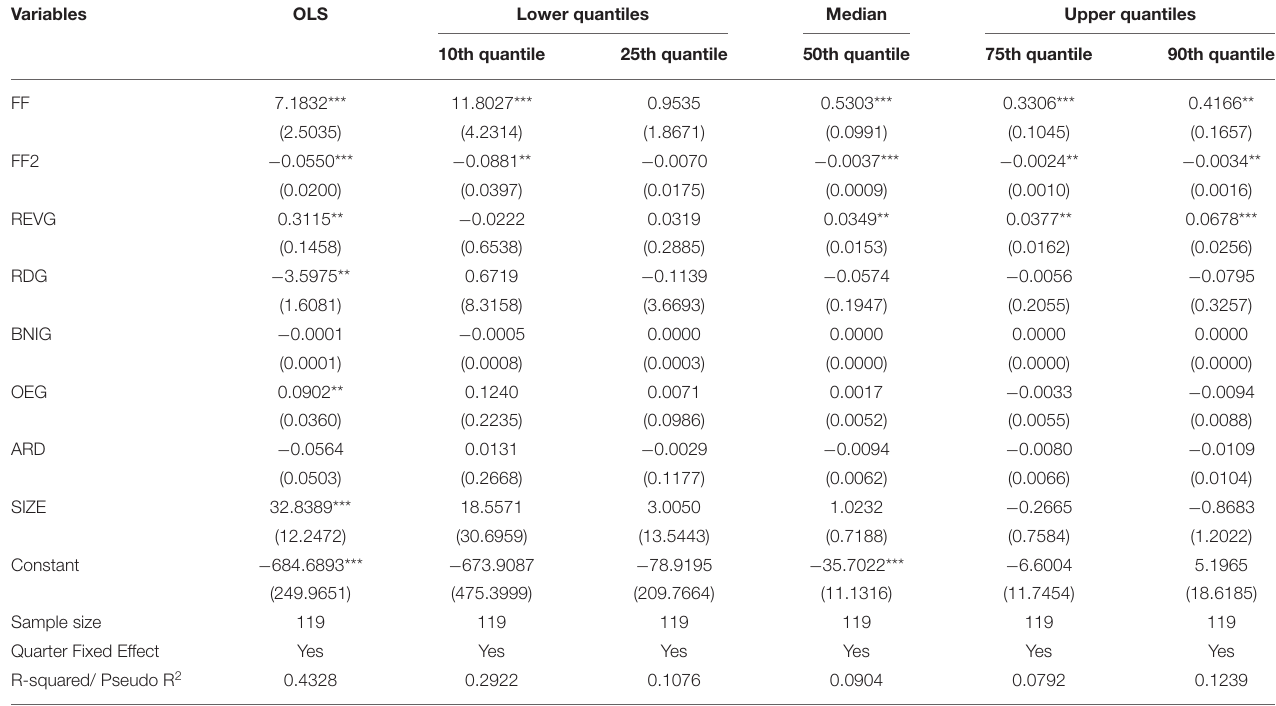
TABLE 4 | Regression results during the COVID-19 pandemic period.